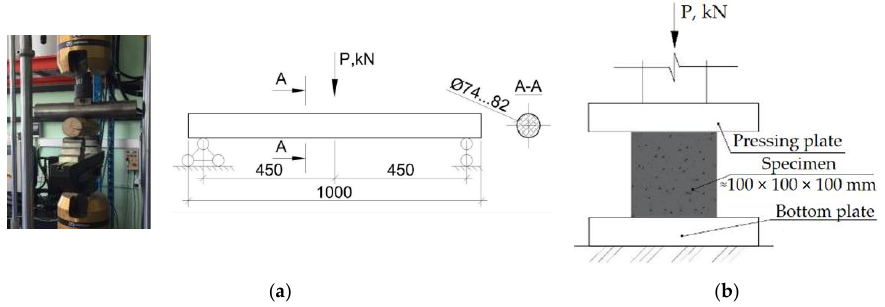
Figure 9. Laboratory tests for cordwood components: ( a ) testing of wood billets; ( b ) testing of clay and mortar cubes.